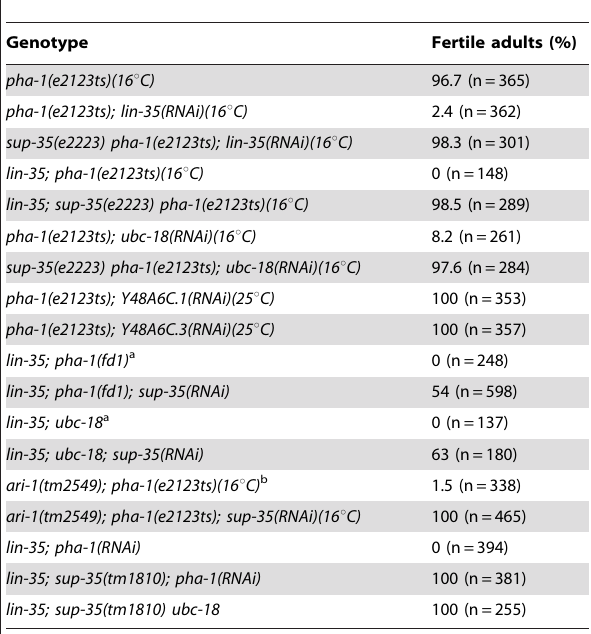
Table 1. Suppression of multiple genotypes by sup-35